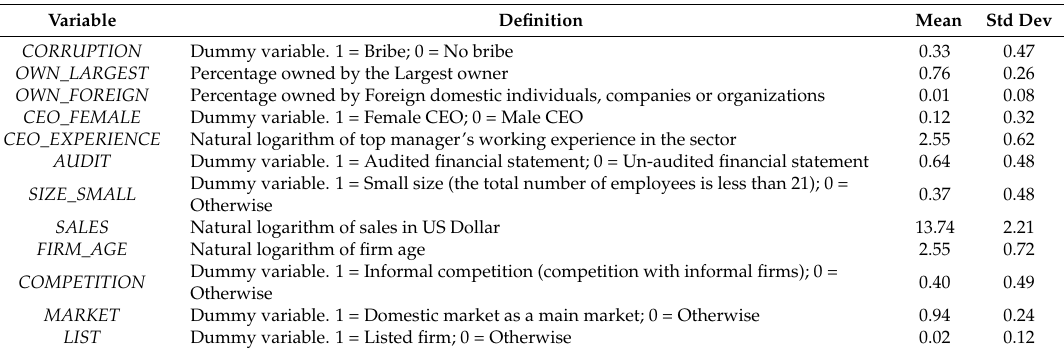
Table 4. Descriptive Statistics (Total Observations =